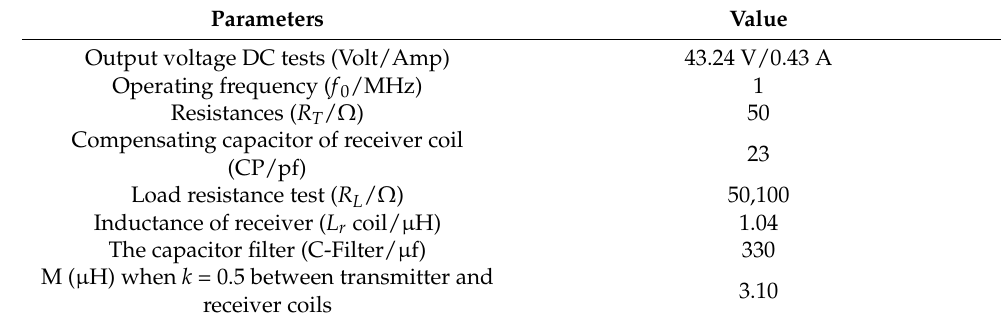
Table 2. Parameters of the STLAC receiver coil.